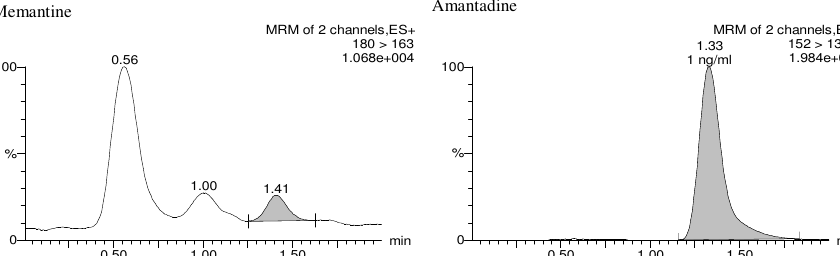
Figure 2. Representative chromatogram of memantine and its internal standard from extracted plasma blank + internal